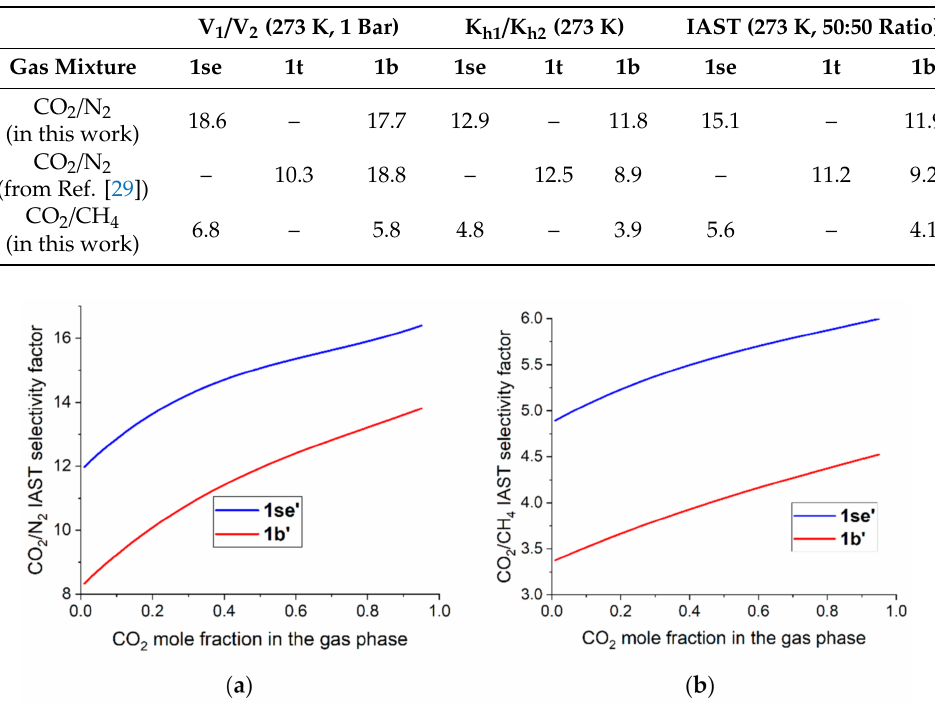
Figure 6. IAST selectivity factors on CO 2 mole fraction in binary gas mixtures: CO 2 / N 2 ( a ) and CO 2 / CH 4 ( b ) at 273K and P total = 1